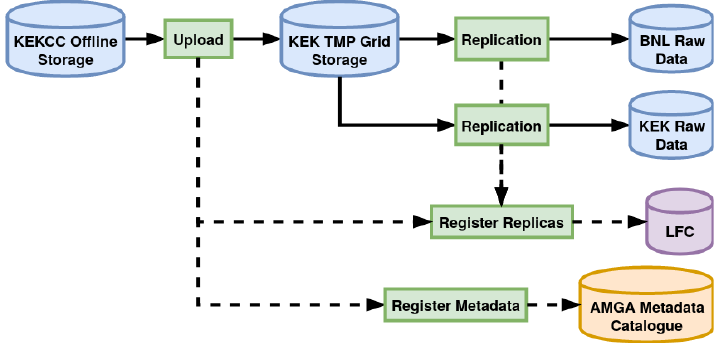
Figure 8. Simplified diagram of the processes completed by